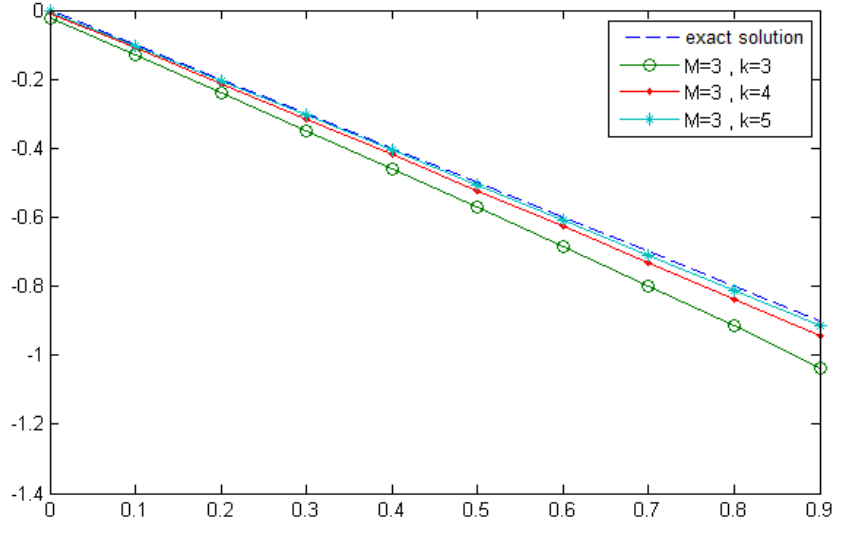
Figure 4. Exact and approximate solutions of y 1 ( t ) for M = 3 and k = 3,4,5 (Example 1).